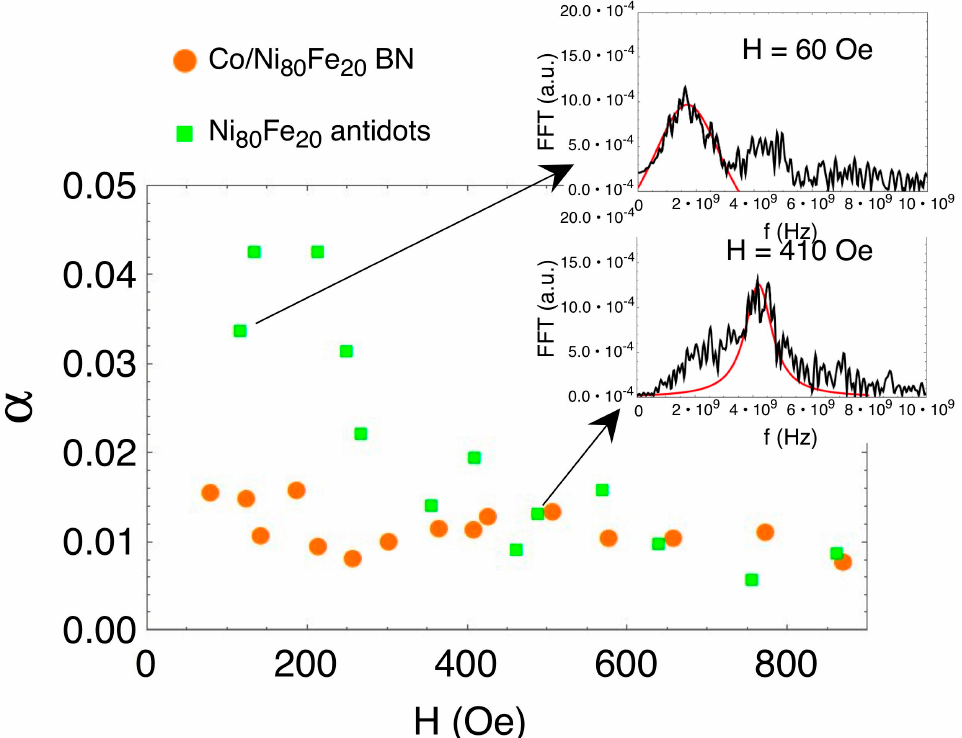
Figure 11. (Colour online) Damping constant α from measurement in a bi-component nanostructured system (orange) and Ni 80 Fe 20 antidot array (green). Insets show examples of Lorentzian fits of the main mode of the antidot sample at 60 and 410 Oe, respectively.